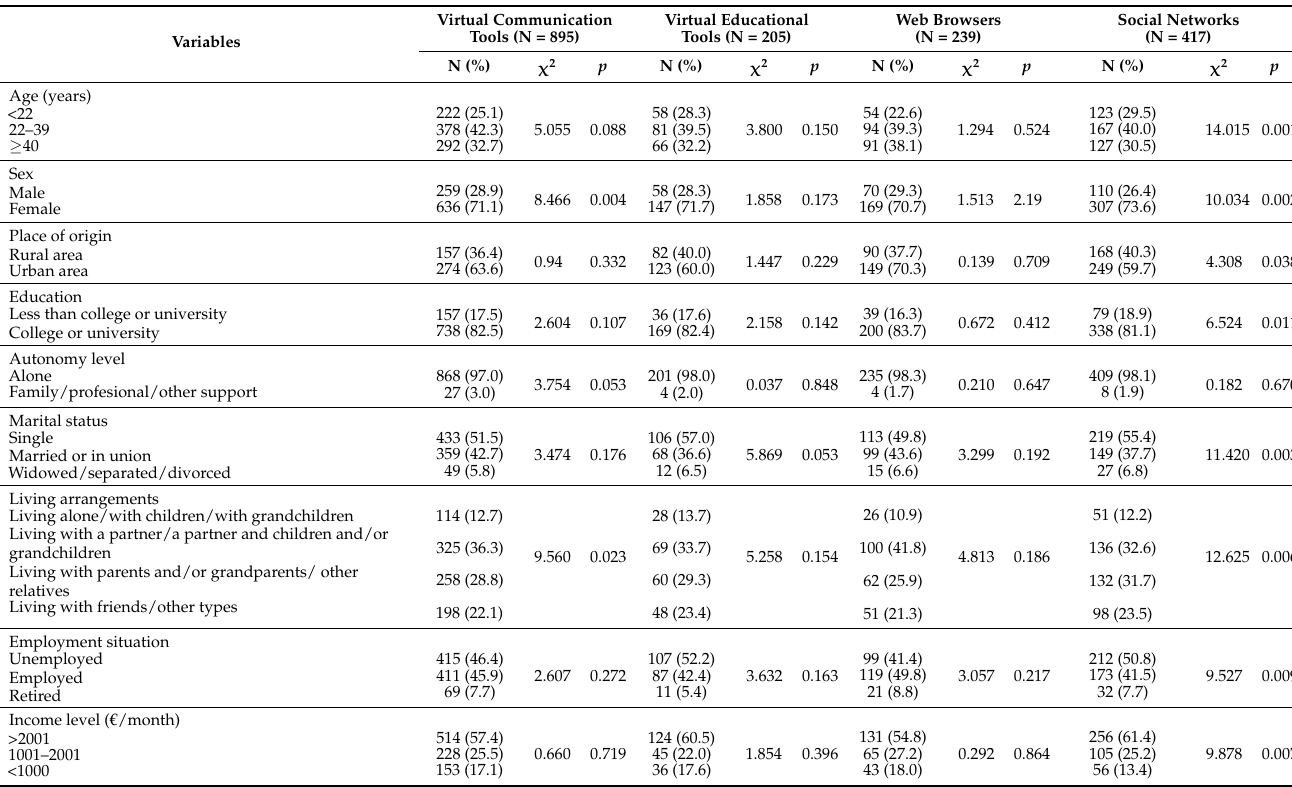
Table 3. Association between performing virtual activities with people of different generations and the sociodemographic characteristics of the